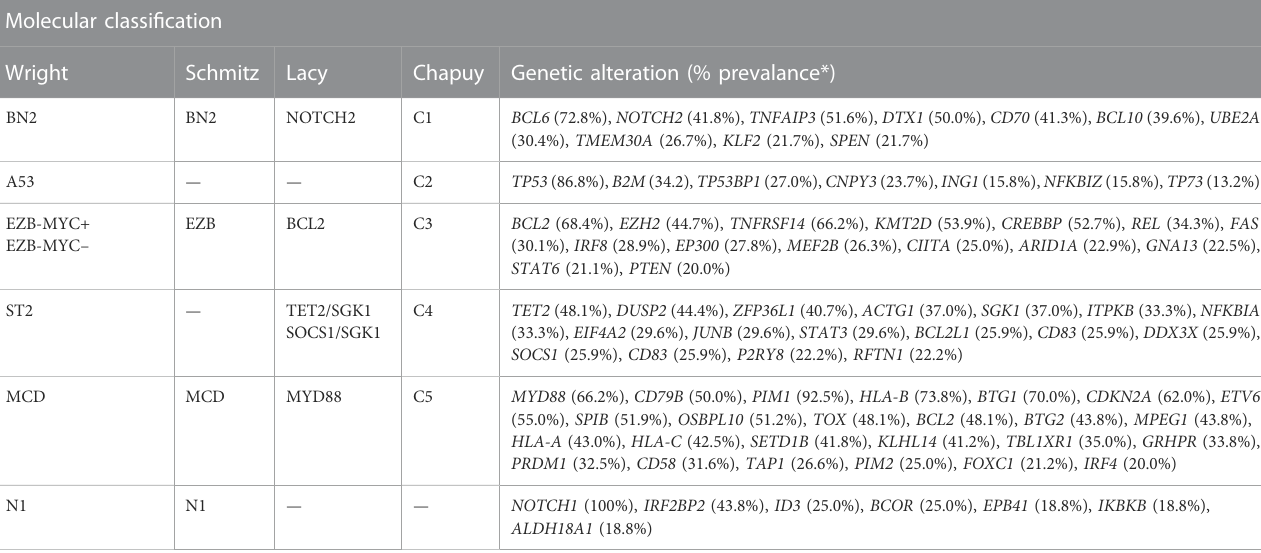
TABLE 1 Molecular classi fi cation of DLBCL. *Prevalance data were extracted from the results published by Wright et al.